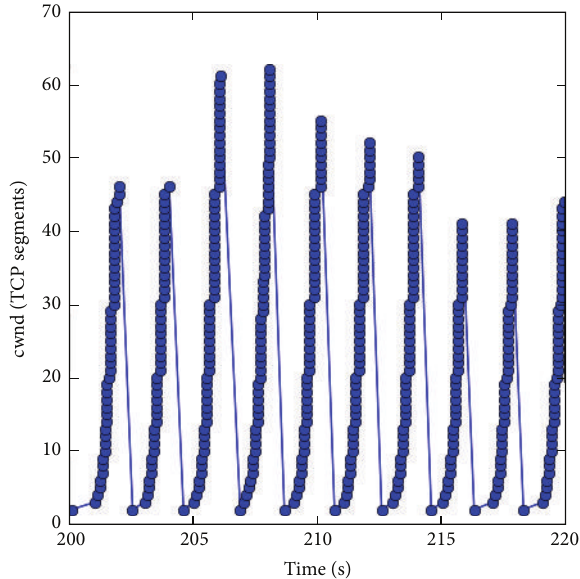
Figure 5: Observed TCP congestion window for 2-second seg-